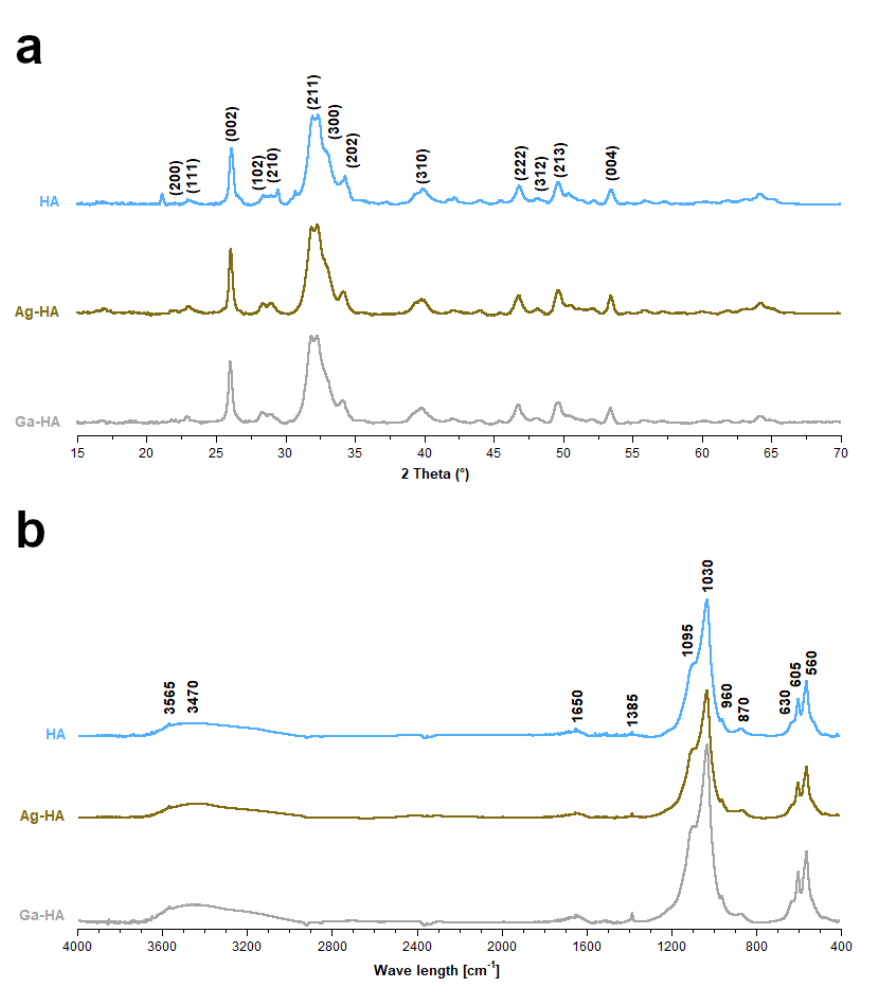
Figure 1. Powder X-ray diffractograms ( a ) and FT-IR spectra ( b ) of the synthesized powder samples.